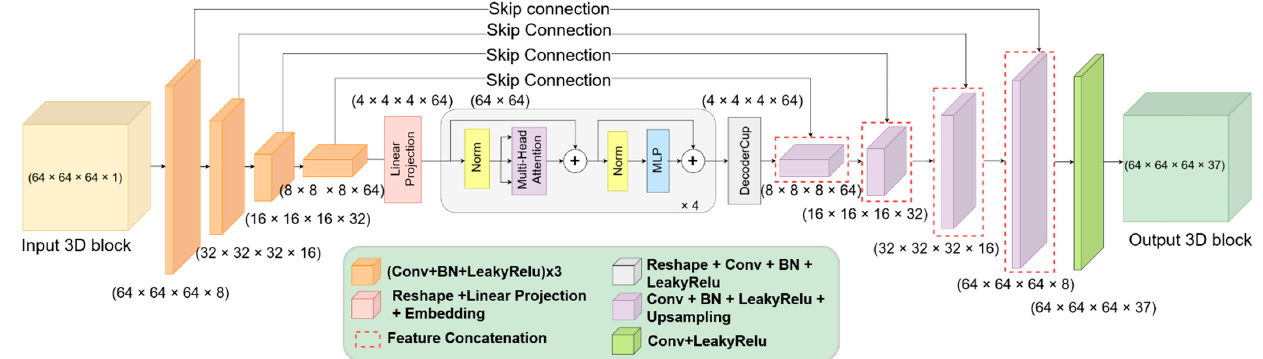
Figure 2. Deep neural network architecture for 3D brain MRI segmentation. The encoder part is composed of convolutional layers and Transformer layers, while the decoder has combinations of convolutional neural networks with upsampling layers.